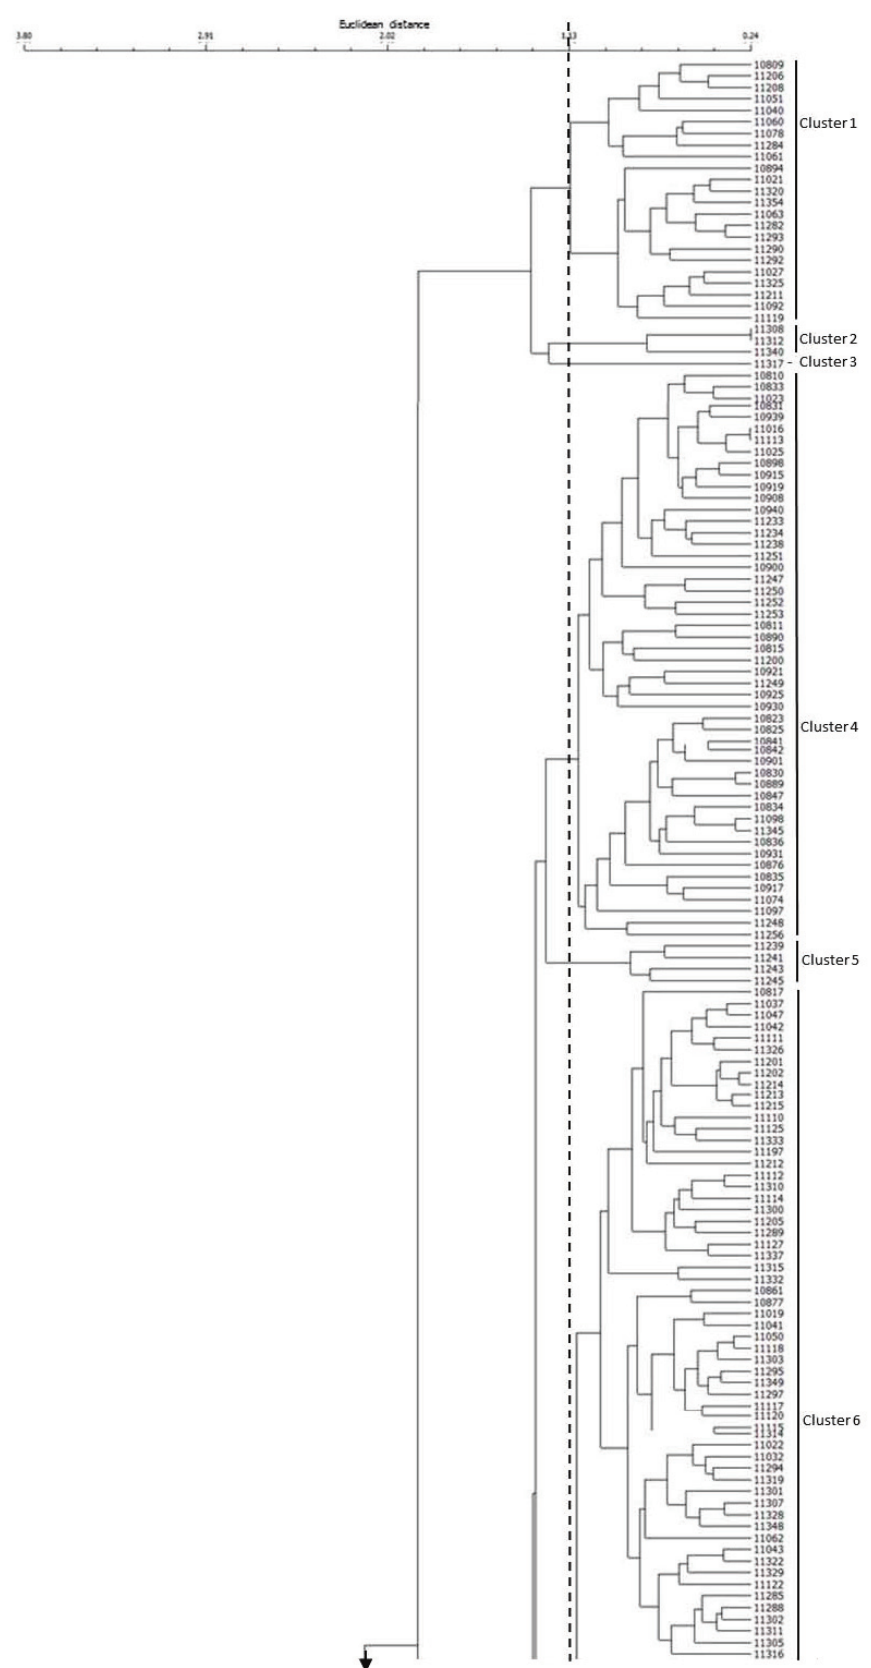
Figure 3. Dendrogram generated by cluster analysis of morphological characters using Unweighted Pair Group Method with Arithmetic Mean